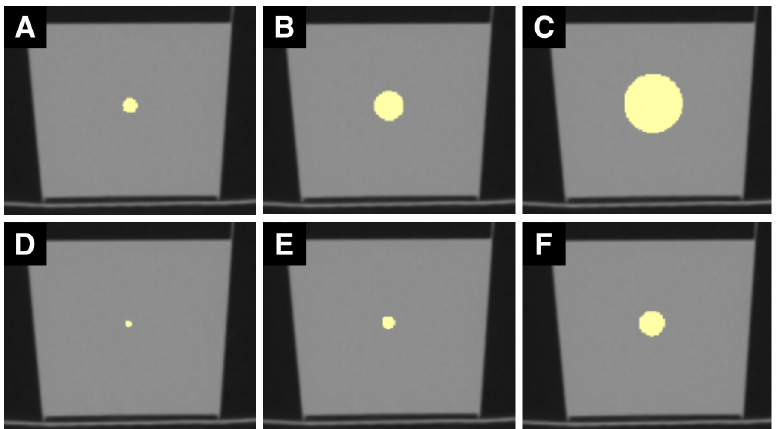
Figure 2. Sample set of CT ROIs. ( A – F ) are CT images of the phantom. ( A ) shows a ROI with a 4 mm diameter, ( B ) with 8 mm, and ( C ) with 16 mm. ( D ) illustrates one slice of the 4-pixel diameter ROI, ( E ) of the 8-pixel, and ( F ) of the 16-pixel diameter ROI. mm sized ROIs are generally larger than px sized ROIs.